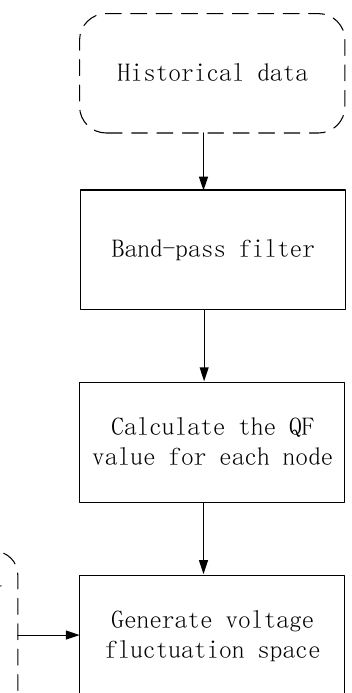
Figure 4. Overview of the node selection